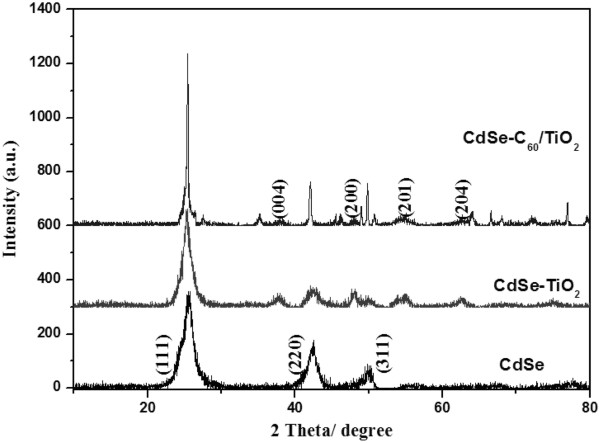
XRD patterns of CdSe, CdSe-TiO2, and CdSe-C60/TiO2.